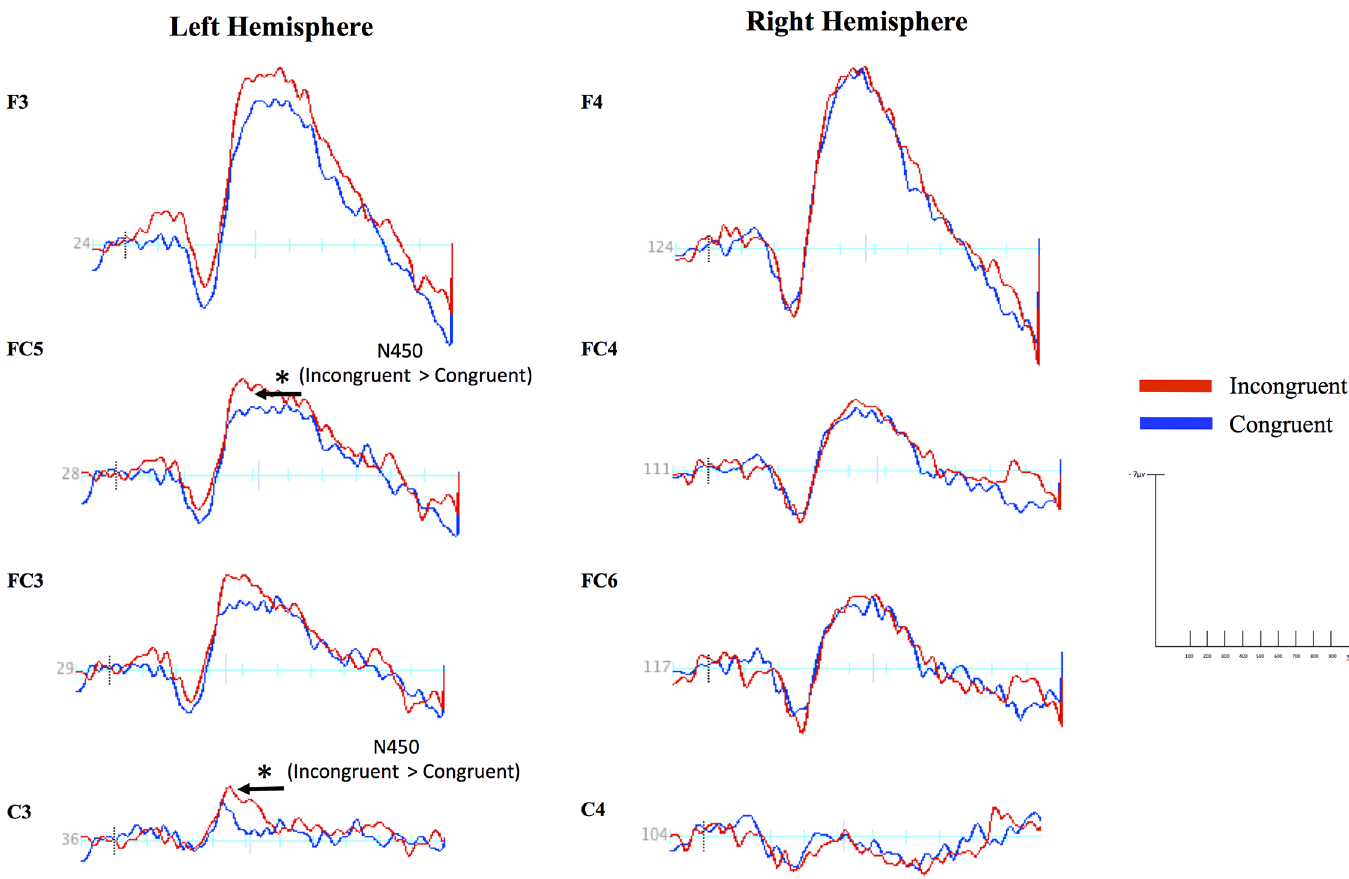
Fig 3. Electrocortical responses differed by Stroop condition in the left hemisphere. Average event-related brain potential (ERP) waveforms (in microvolts) for incongruent (red lines) and congruent trials (blue lines) at all locations. Asterisks ( * ) denote statistical differences between incongruent and congruent trials for the N450 ERP with a significance level at p < .01, while arrows with ( t ) indicate a trend at p < 0.10.